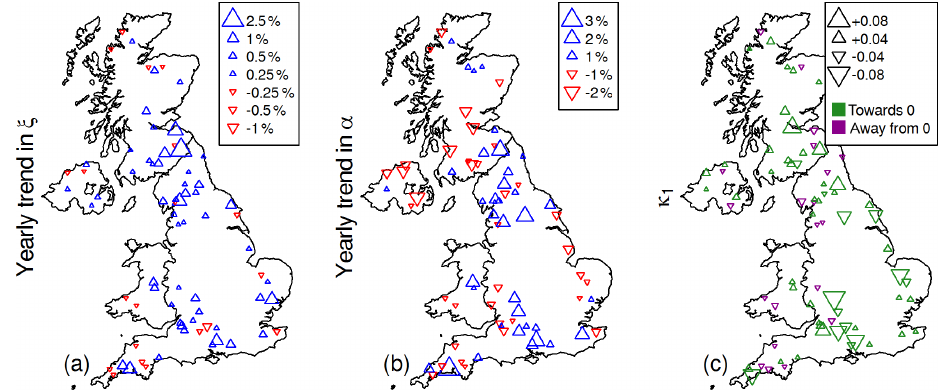
Figure 5. Maps of the UK Benchmark Network showing relative spatial trends in ξ (a) , α (b) , and κ 1 (c) .